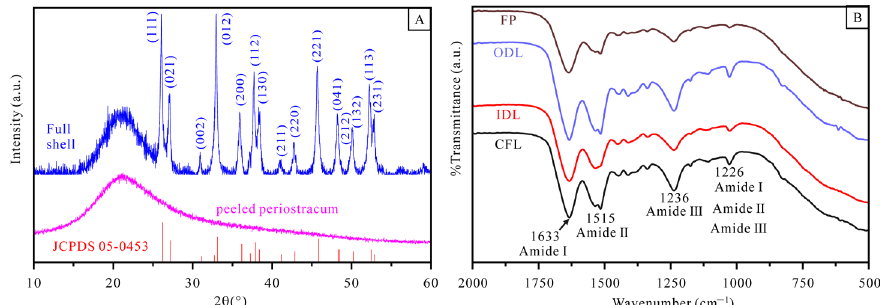
Figure 2. ( A ) XRD patterns of the periostracum and full shell. ( B ) The ATR-FTIR spectra of the periostracum. FP: Full periostracum, ODL: outer dense layer, IDL: Inner dense layer, CFL: Central fibrous layer.